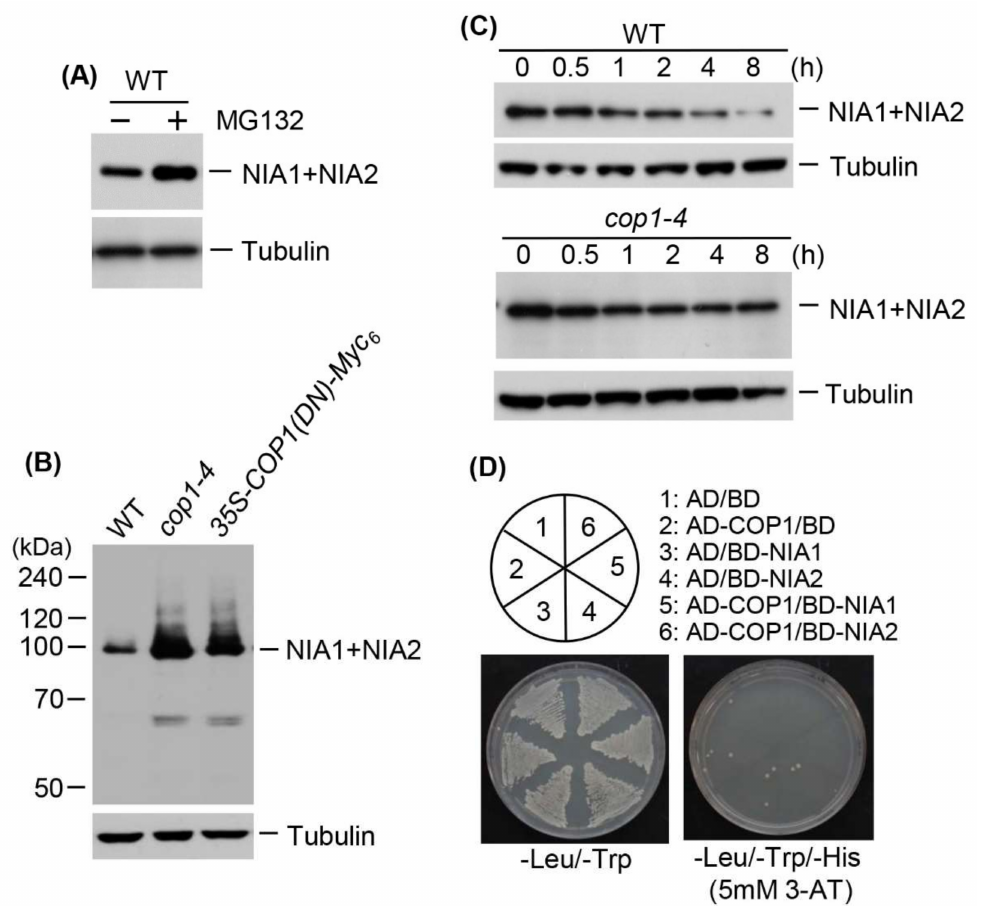
Figure 5. Effect of COP1 on nitrate reductase levels. ( A ) Total proteins were extracted from wild-type plants treated with 100 µ M MG132, and NR proteins (NIA1 + NIA2) were detected by immunoblotting with an anti-NR antibody; tubulin was used as a loading control; ( B ) Examination of NR protein levels in cop1-4 and 35S-DN-COP1-Myc 6 transgenic plants. Total proteins were extracted from wild-type, cop1-4 , and 35S-DN-COP1-Myc 6 transgenic plants grown for 15 d, and NR proteins (NIA1+NIA2) were detected by immunoblotting with an anti-NR antibody; tubulin was used as a loading control; ( C ) Cell-free degradation analysis of NR proteins in cop1-4 and cop1-6 . Total proteins were extracted from wild-type and cop1-4 plants treated with 100 µ M cycloheximide for the indicated times and NR proteins (NIA1 + NIA2) were detected by immunoblotting with an anti-NR antibody; tubulin was used as a loading control; ( D ) Yeast two-hybrid analysis of the interactions between COP1 and NR proteins. Full-length COP1 was fused to sequences encoding the Gal4 activation domain (AD) in pGAD424. NIA1 and NIA2 cDNA were fused to sequences encoding the Gal4 DNA-binding domain (BD) in pGBT8. The constructs were transformed into yeast strain AH109. Numbers indicate yeast cells transformed with only pGAD424 and pGBT8, or with recombinant plasmids. Transformants were plated onto minimal medium, − Leu/ − Trp and − Leu/ − Trp/ − His (5 mM 3-AT), and incubated for 4 d prior to